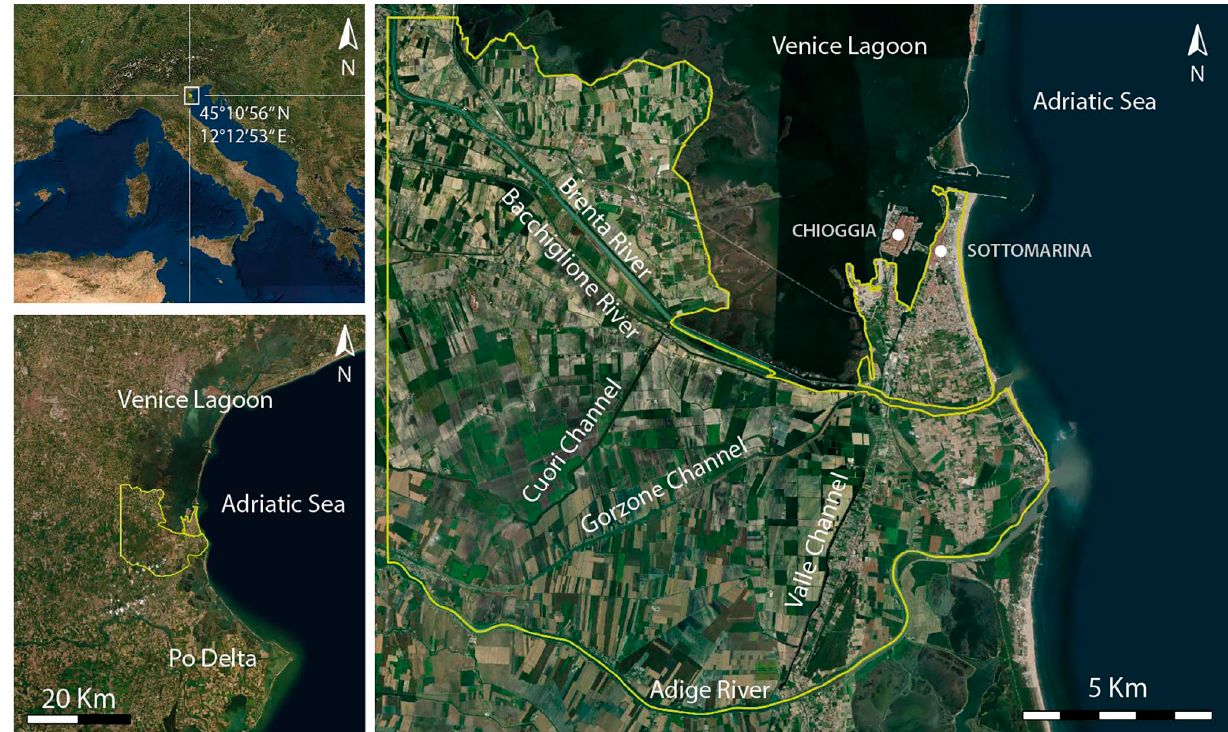
Figure 1. Location of the study area (yellow polygon) on the coast of the Northern Adriatic Sea, Italy. Base map source: Esri, Maxar, Earthstar Geographics, USDA FSA, USGS, Aerogrid, IGN, IGP, and the GIS User Community.